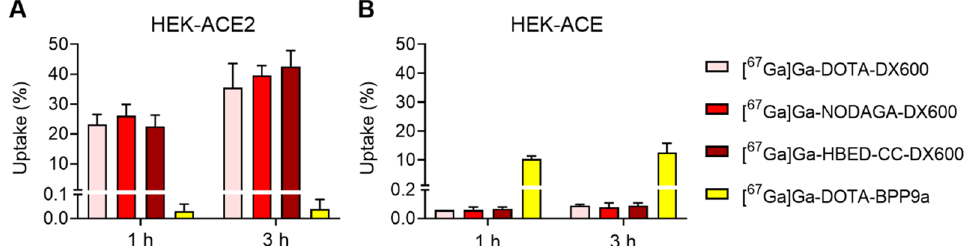
Fig. 5 Uptake of the radiopeptides in A HEK‑ACE2 and B HEK‑ACE